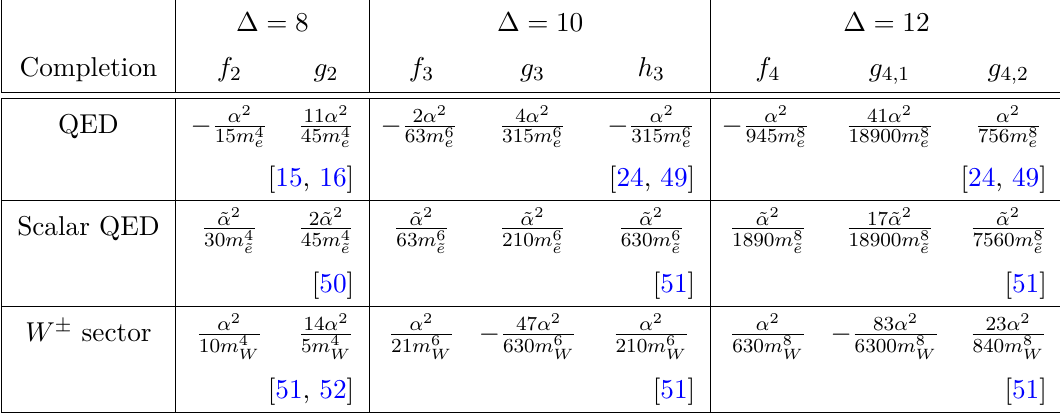
. Recall from (1.4) i